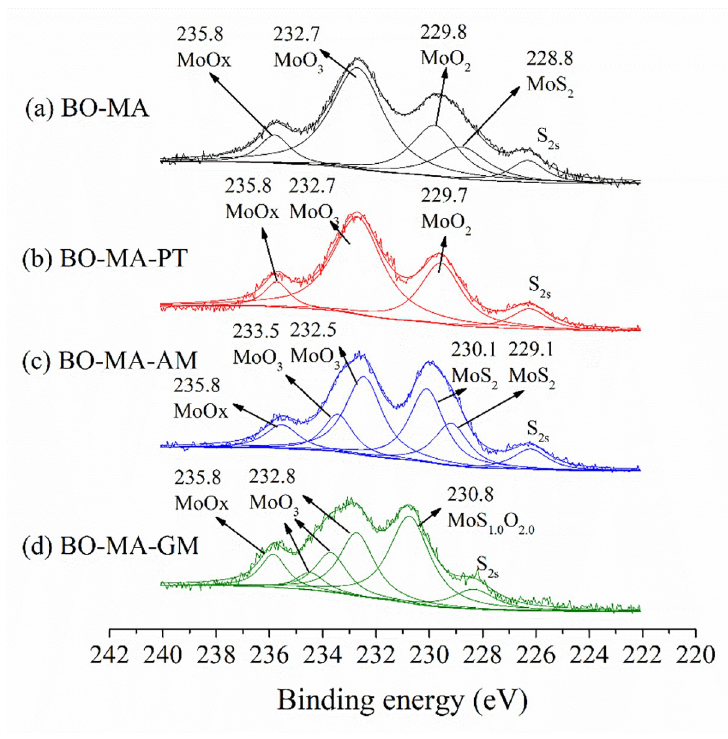
Fig 13. Friction surface XPS photopeaks of Mo3d lubricated with Molybdenum Amide (MA) containing lubricants.